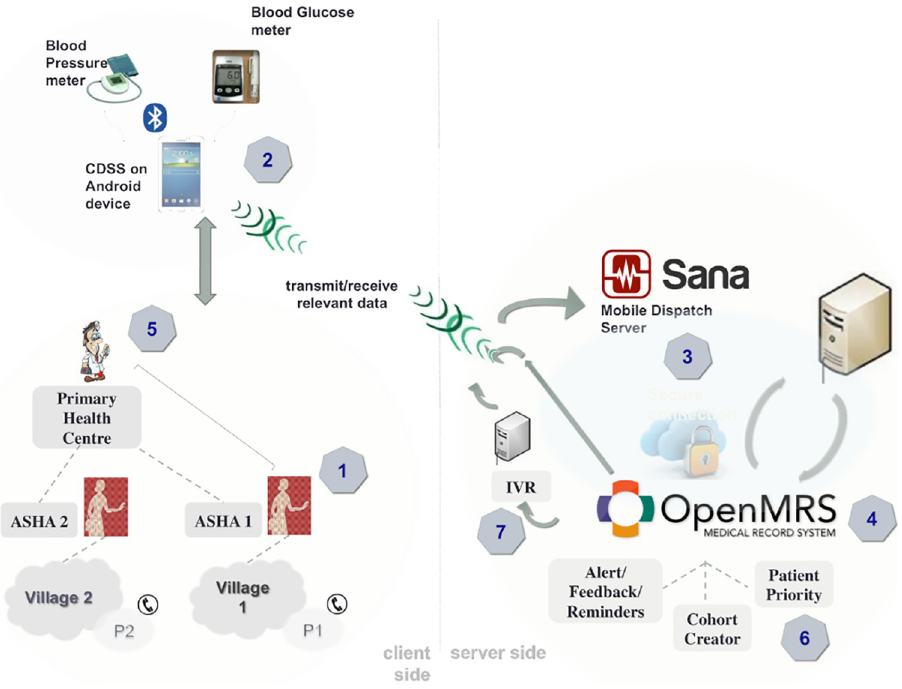
Fig 1. Intervention components. CDSS: Clinical Decision Support System; ASHA: Accredited Social Health Activist.